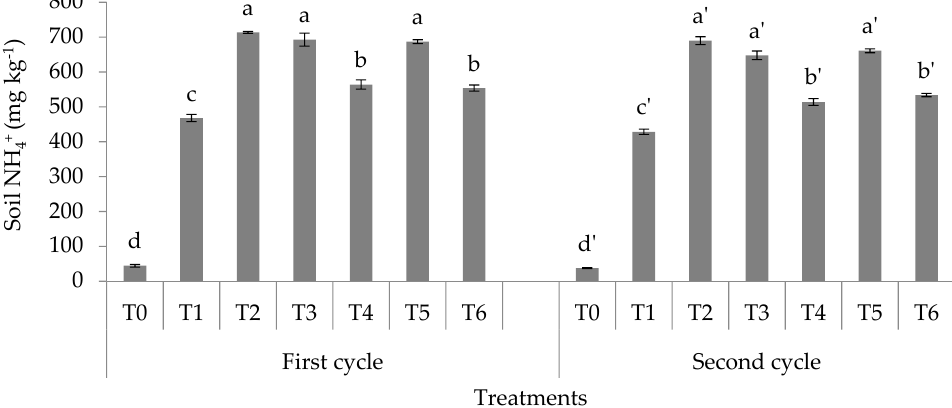
Figure 8. Effects of treatments on soil exchangeable ammonium. Means with the same letter above the bars within a crop cycle are not significantly different at p ≤ 0.05. Bars represent the mean values ± standard error .